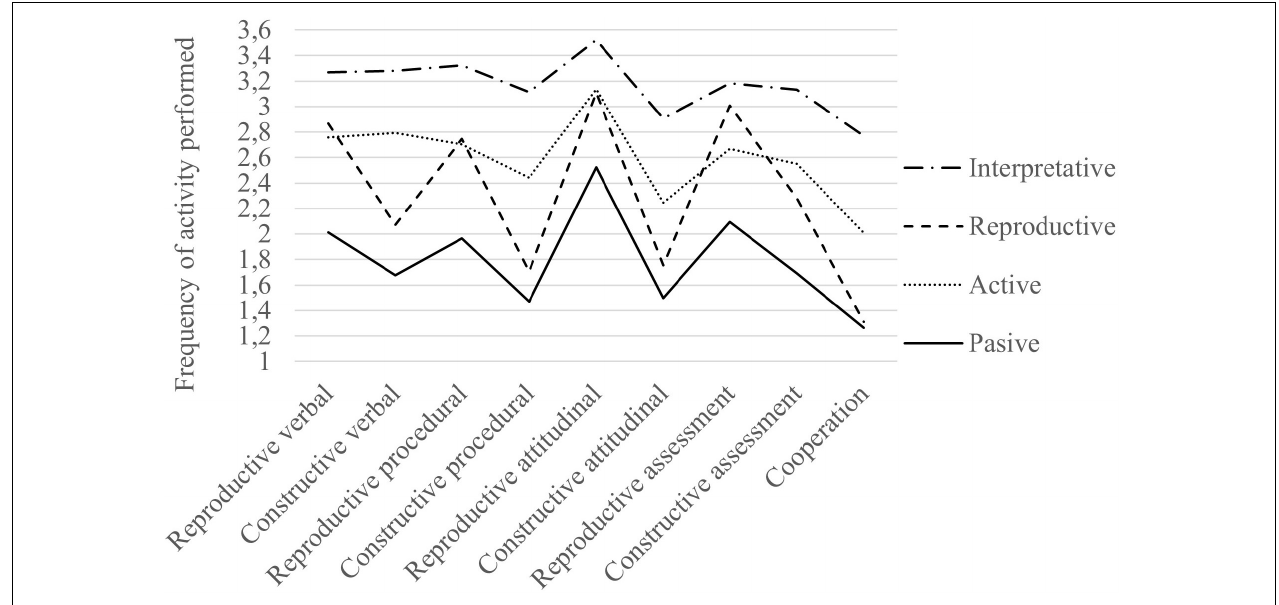
FIGURE 4 | Use of each dimension for each teachers’ profile. TABLE 7 | Variables related to each of the